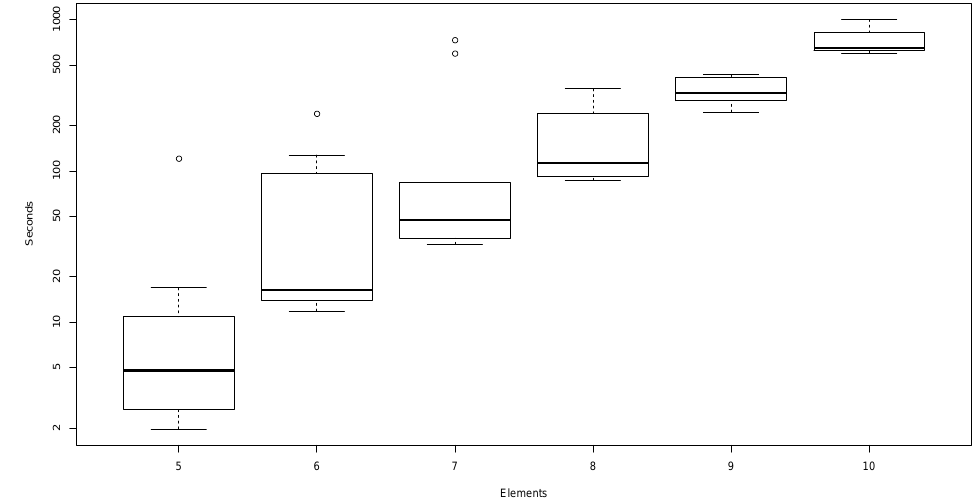
Figure 7. GA efficiency (time versus number of elements). Tested on Pentium 4—2.8 GHz. Improvement— (no superexponentiality)